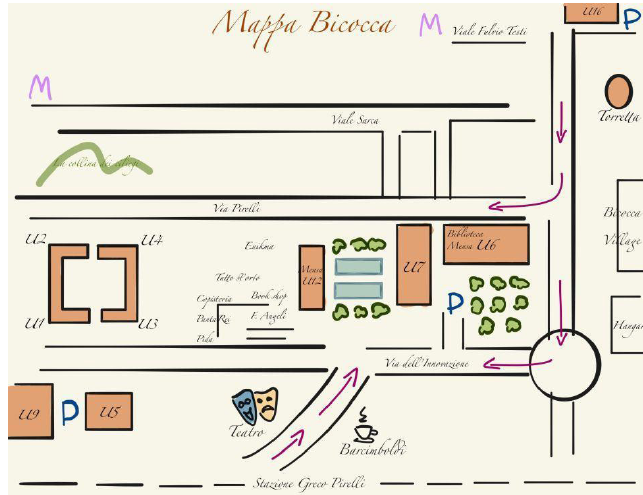
Figure 2 Drawing from the first workshop – Bicocca from a PhD Student’s point of